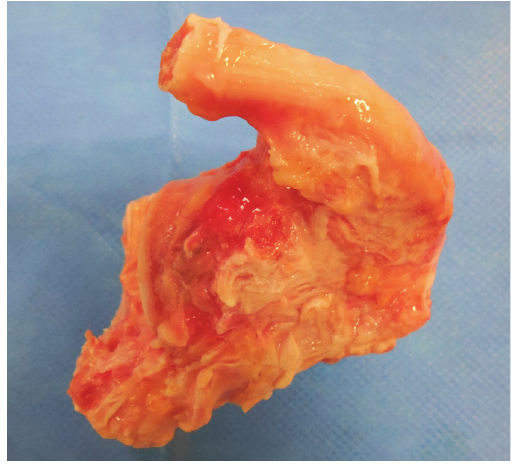
Figure 2: Photograph of the total calcaneal allograft with the distal extremity of the Achilles